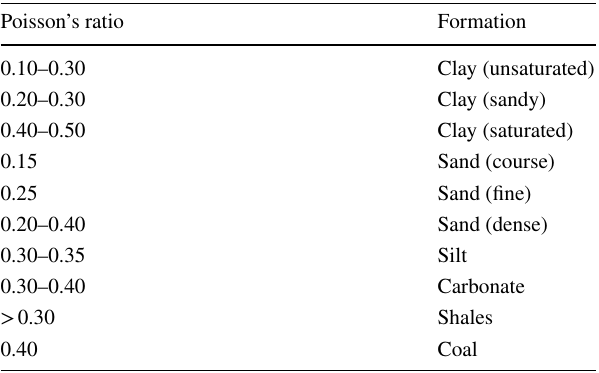
Table 1 Poisson’s ratio for different formations. Source :